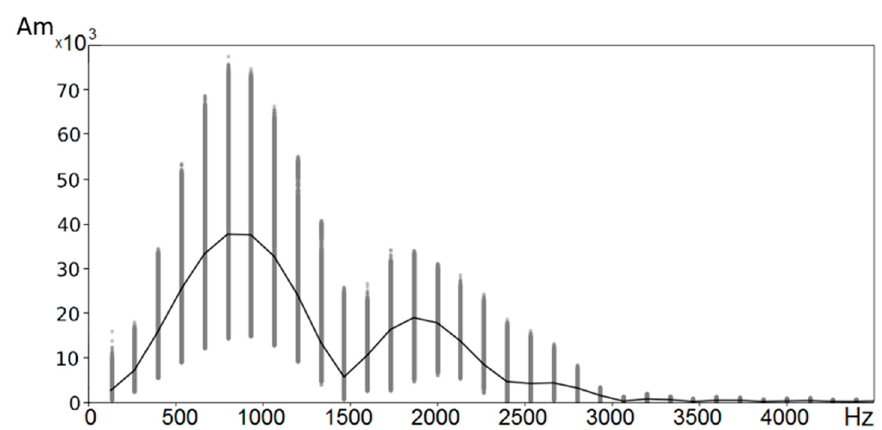
Figure 7. The values of the spectra of the analyzed signals.